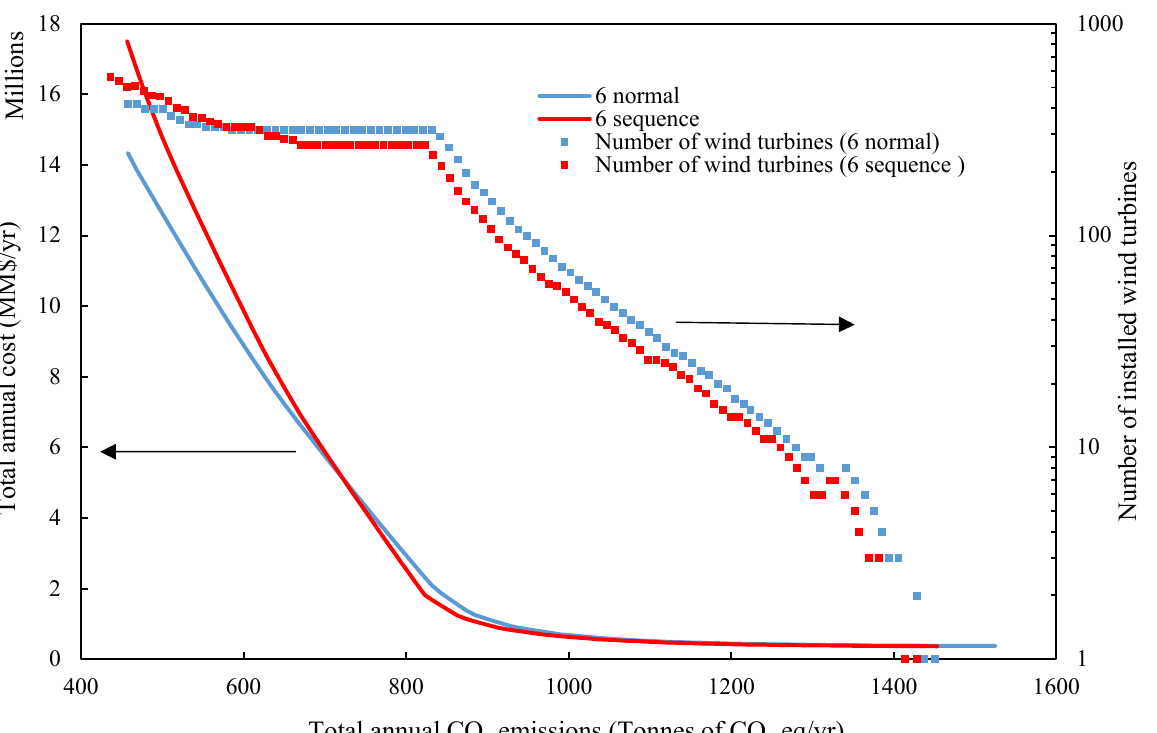
Figure 9. Effect of CO 2 emissions regulation on the objective function (lines) and number of wind turbines (square marker).